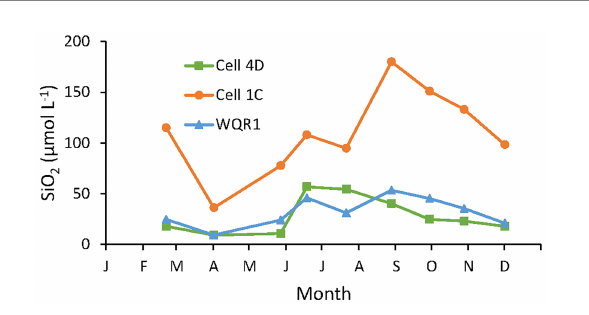
FIGURE 5 Ambient 2014 water column concentrations of DSi in Cell 4D